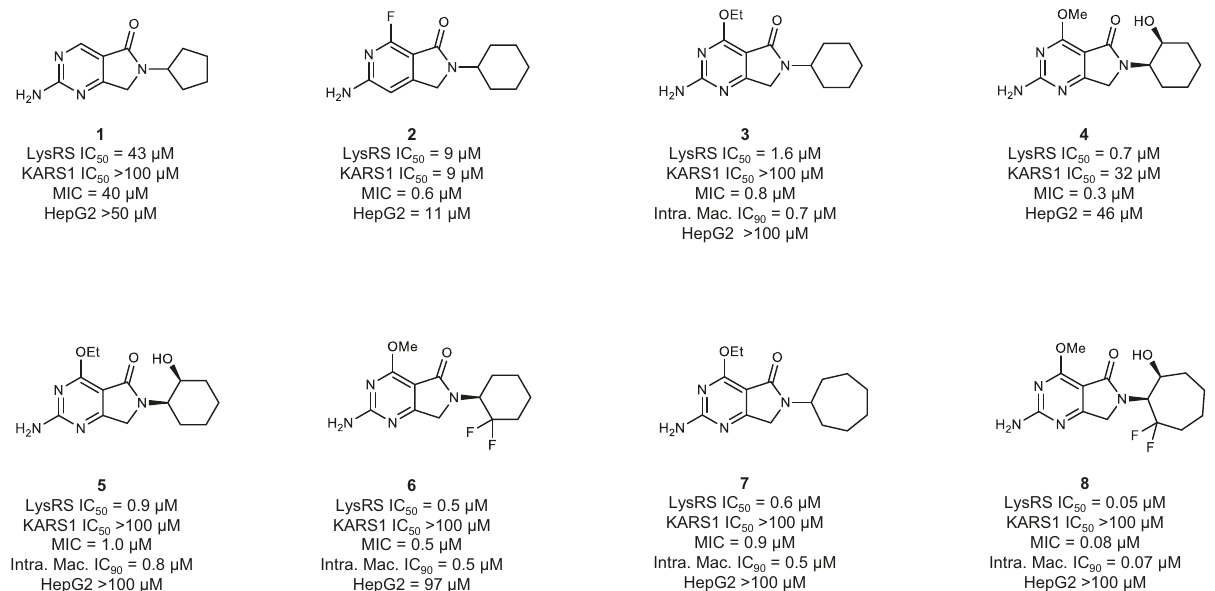
Fig. 1 | Chemical evolution of DDD2049209 ( 8 ) from the initial hit 1 . Potencies are shown against: in vitro enzymes LysRS & KARS1; M. tuberculosis phenotypic growth in culture (MIC), M. tuberculosis growth within macrophages, and